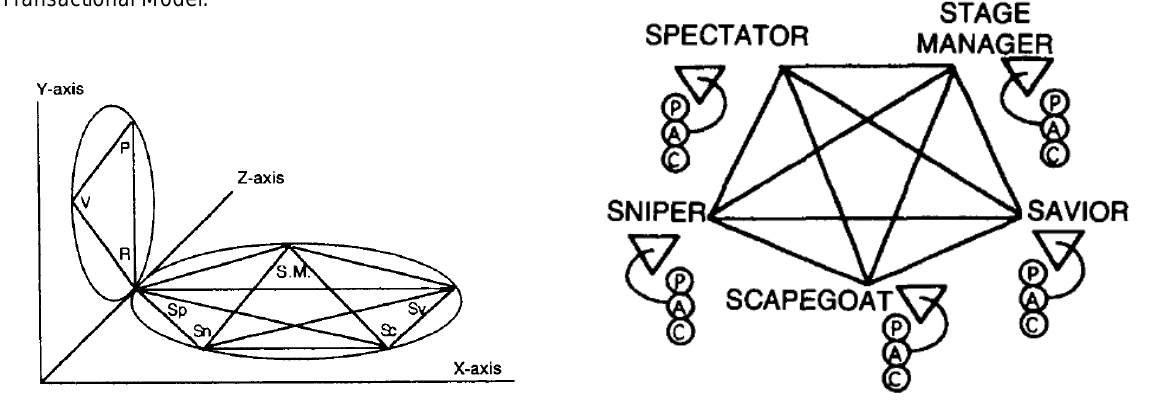
Figure 6: Diagram of the Individual on the Drama Triangle and the Game Pentagon (Summerton, 1993b, p.33)